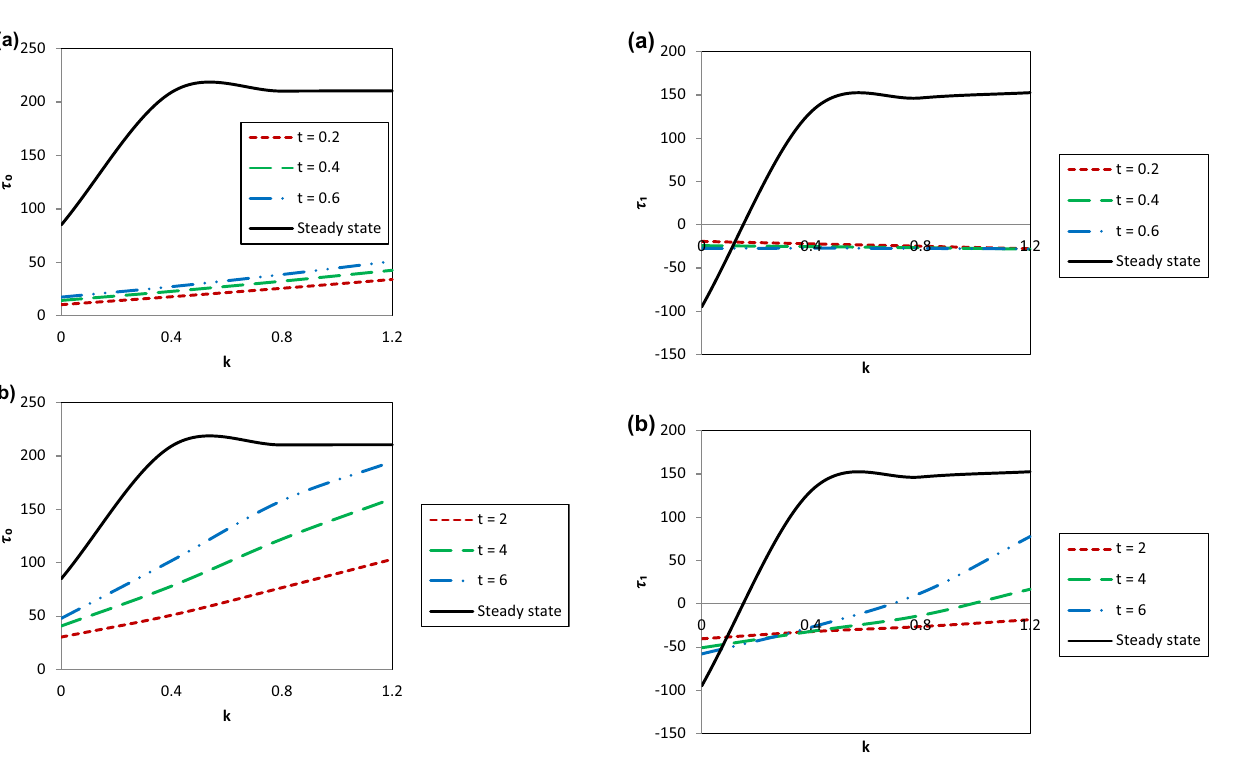
Fig. 4 a Variation of skin friction versus dimensionless thermopho- retic coefficient for different values of time at 𝛼 = 10, Bi 1 = Bi 2 = 10 ) y = 0 ( Pr = 0.71, Sc = 100, 𝜆 = 100, b = 10, N c = 2.0, N t = 8.0, . b Variation of skin friction versus dimensionless thermophoretic coefficient for different values of time at y = 0 ( Pr = 0.71, Sc = 100, 𝜆 = 100, = 2.0, N = 8.0, 𝛼 = 10, Bi = Bi = 10 ) b = 10, N 1 2 c t